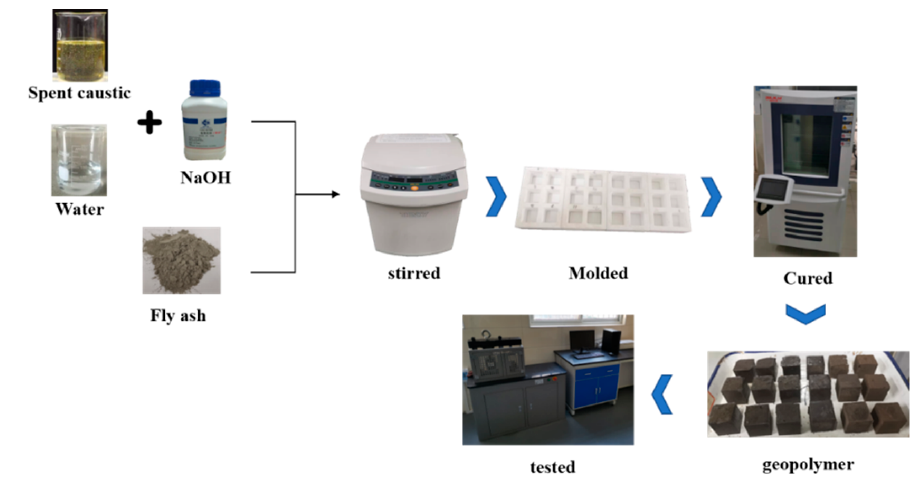
Figure 2. The diagram of the geopolymer preparation process. Table 2. Preparation regime of geopolymers. Specimen No.